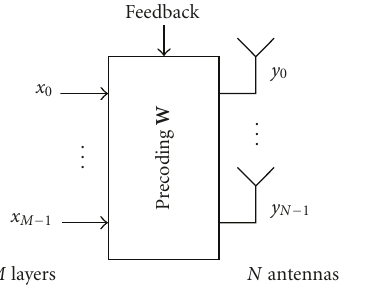
Figure 1: Closed-loop spatial multiplexing with N antennas and M layers.